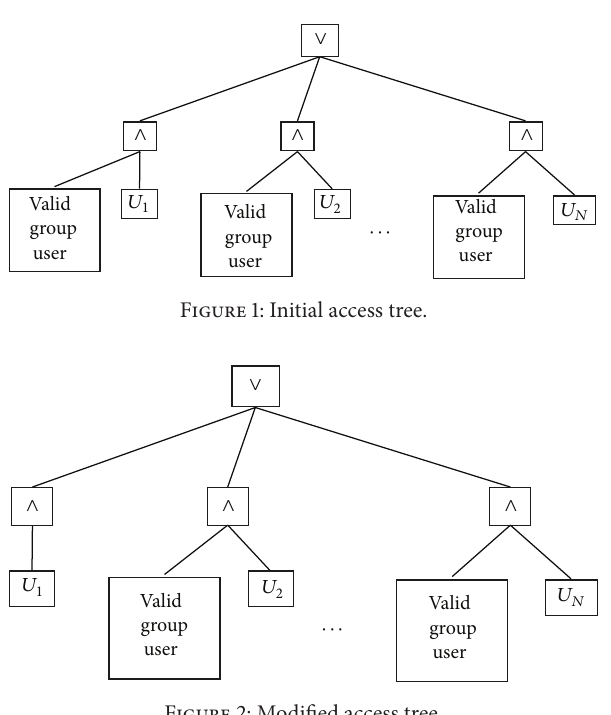
Figure 2: Modified access